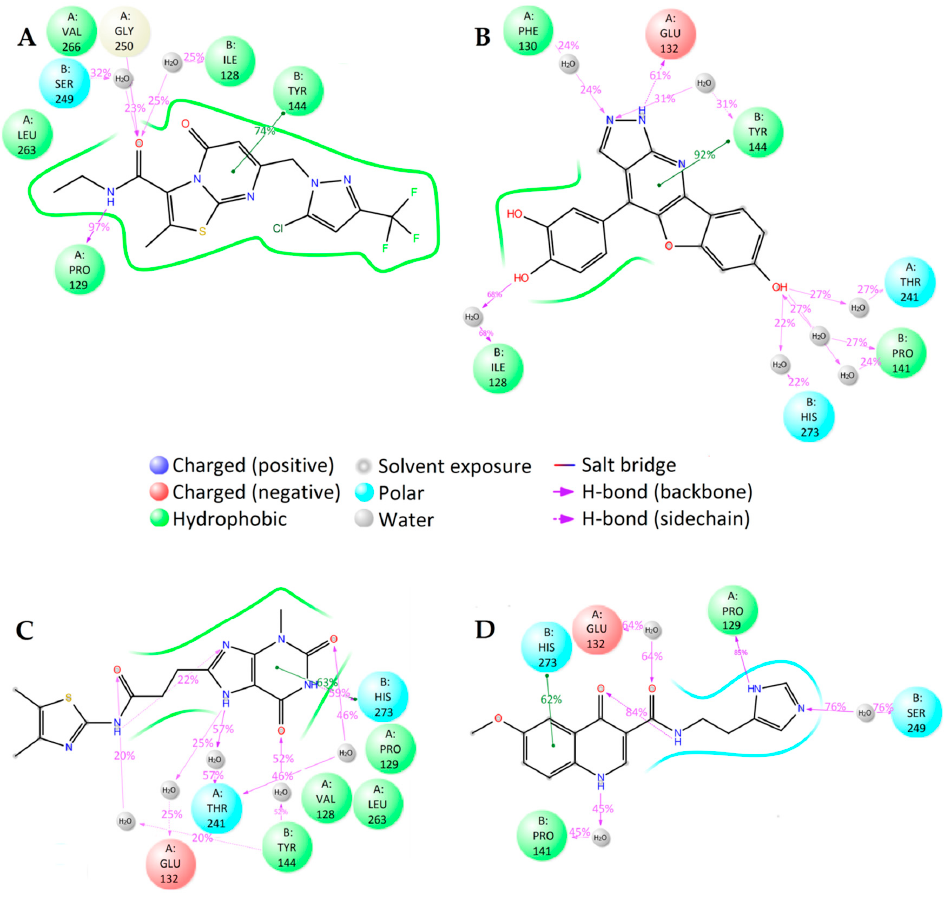
Figure 4. 2D summary of molecular dynamics calculated contacts between NMDA and compounds ( A ) GNE-5729, ( B ) 1N , ( C ) 2N , and ( D ) 3N .